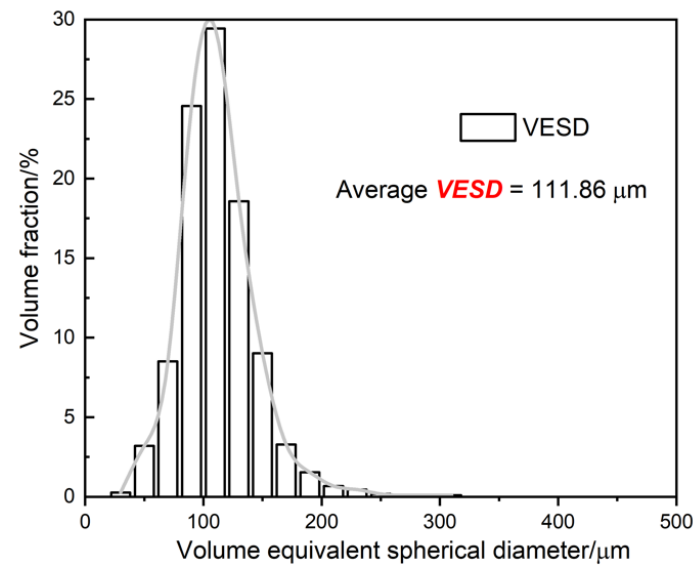
Figure 6. Volume-based distribution histogram for VESD .